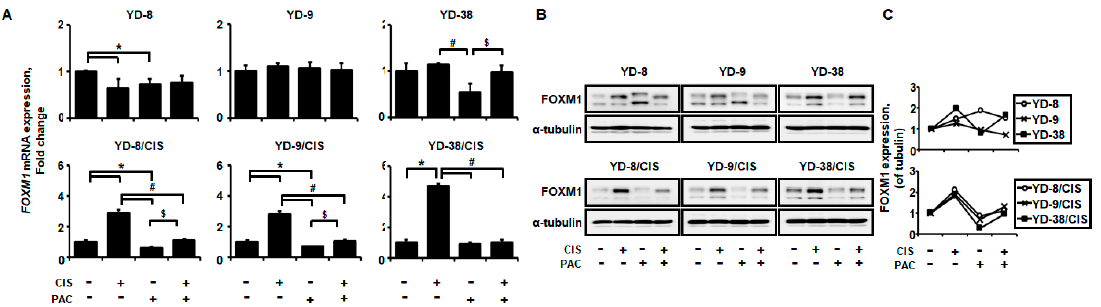
Figure 2. Cisplatin (10 μ g/mL) incubation for 6 h induces overexpression of FOXM1 mRNA and protein in cisplatin-resistant cell lines, whereas combination treatment attenuates this increase. ( A ) The expression of FOXM1 mRNA from these six cell lines treated with cisplatin in the presence or absence of paclitaxel was determined by real-time qRT-PCR (mean ± SD; n = 3). * p < 0.05 versus non-treated group, # p < 0.05 versus only cisplatin-treated cells, and $ p < 0.05 versus only paclitaxel-treated cells. ( B ) The expressions of FOXM1 and α -tubulin in cell lysates from these six cell lines treated with cisplatin in the presence and absence of paclitaxel were determined by Western blot assay. ( C ) Quantification of Western blot results.